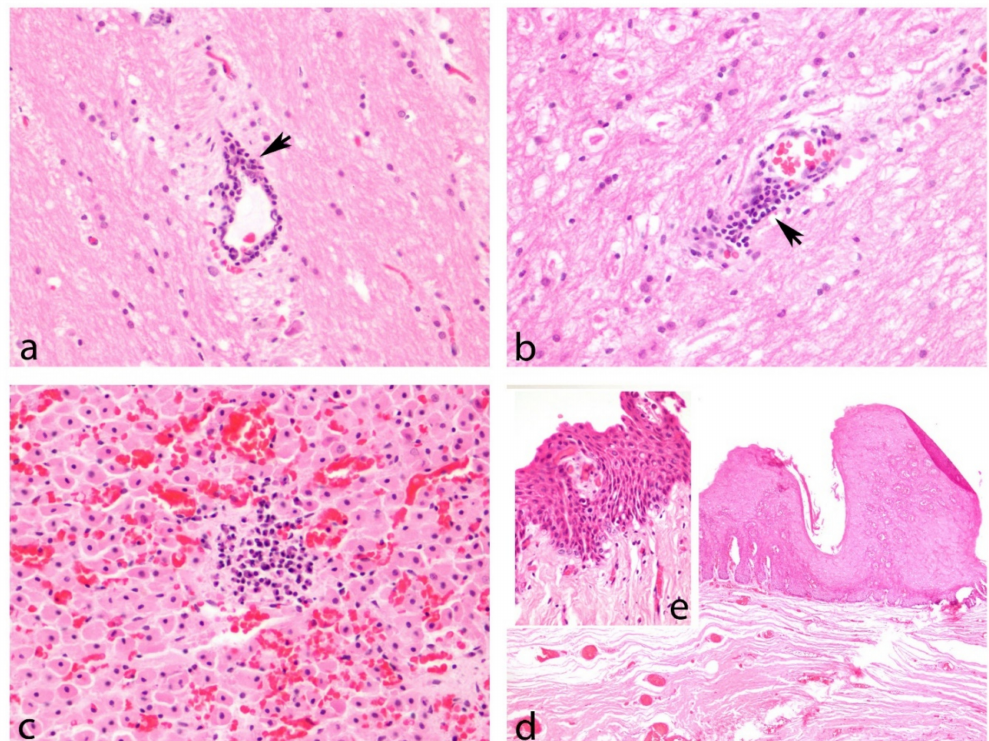
Figure 9. Histopathological images of representative lesions. Hematoxylin–eosin stains. ( a , b ) Striped dolphin, brain, 40 × . Lymphoplasmacytic meningoencephalitis associated with GHV infection in the CNS. Perivascular cuffs of lymphocytes, plasma cells, and few histiocytes (arrow) in cerebral white matter. ( c ) Striped dolphin, adrenal gland, 40 × . The zona fasciculata of the adrenal cortex contains a small, nodular infiltrate of lymphocytes and plasma cells, which separate and extend between adjacent spongiocytes. Diffusely, the cortical sinusoids are markedly congested. ( d ) Risso’s dolphin, penis, 4 × . A well demarcated area of mucosa is markedly hyperplastic, containing numerous layers of squamous epithelium that lay over an irregularly folded basement membrane. ( e ) Detail of the previous lesion at 40 × , showing basal cells piled along the folded basement membrane and mild spongiosis of the cells in the middle layers. Table 2. Relevant histopathological findings in samples with HV infection. Sc: Stenellacoeruleoalba , Tt: Tursiopstruncatus , Gg: Grampusgriseus , Zc: Ziphiuscavirostris , M: male, F: female, U: undetermined, N: neonate, C: calf, J: juvenile, A: